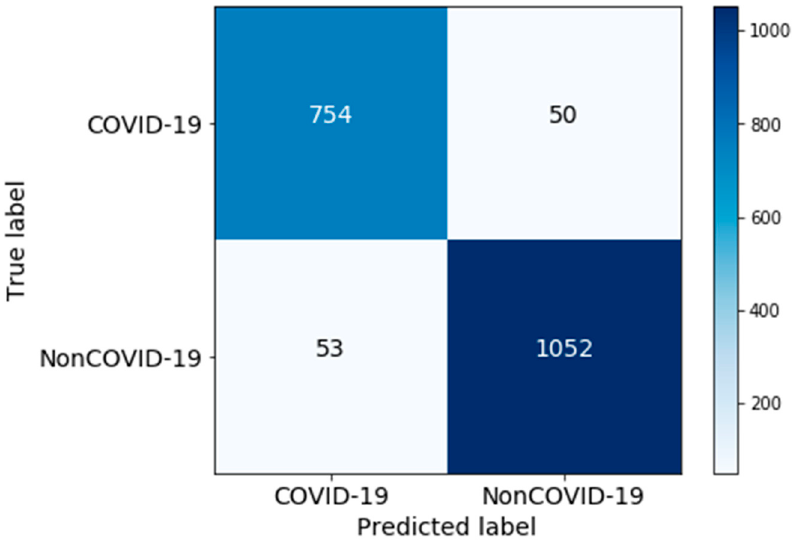
Figure 5. Confusion matrix of DNN model on test set.